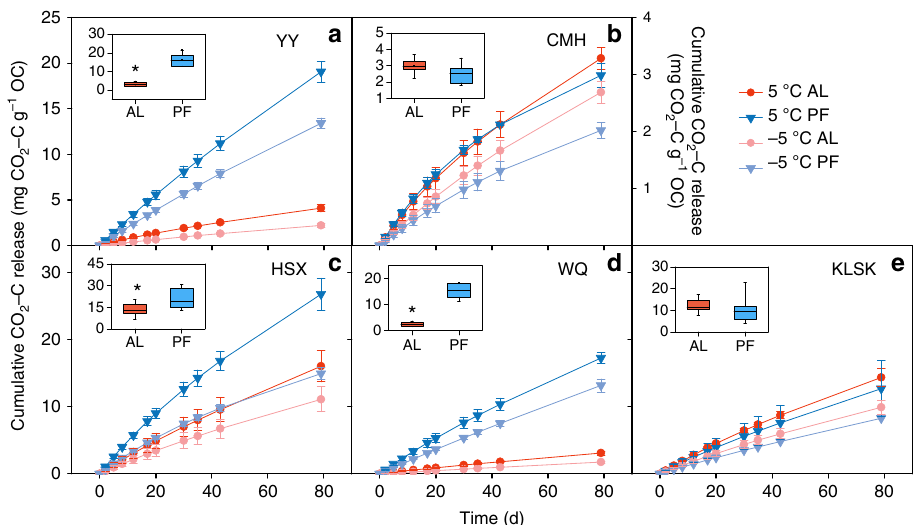
Figure 2 | CO 2 –C release obtained from (cid:2) 5 and 5 (cid:2) C incubations. CO 2 –C release from the active layer (AL, red dots) and permafrost deposits (PF, blue triangles) for five sites was normalized to SOC to represent the apparent SOC decomposability. A higher CO 2 –C release per unit SOC indicates a larger amount of labile C. Values are means ± 1 s.e. ( n ¼ 3). The solid shading corresponds to 5 (cid:2) C incubation and transparent to (cid:2) 5 (cid:2) C incubation. The secondary y axis in b only corresponds to this figure. Included boxplots indicate the comparison of CO 2 –C release between the two soil layers during 80-day incubation at 5 (cid:2) C. The whiskers illustrate the 5th and 95th percentiles, and the ends of the boxes represent the 25th and 75th quartiles (interquartile range). An asterisk indicates significant differences between the two soil layers. The sub-panels correspond to the five study sites: ( a ) Youyun (YY), Maqin County; ( b ) Changmahe (CMH), Maqin County; ( c ) Huashixia (HSX), Maduo County; ( d ) Wenquan (WQ), Xinghai County; and ( e ) Kunlunshankou (KLSK),